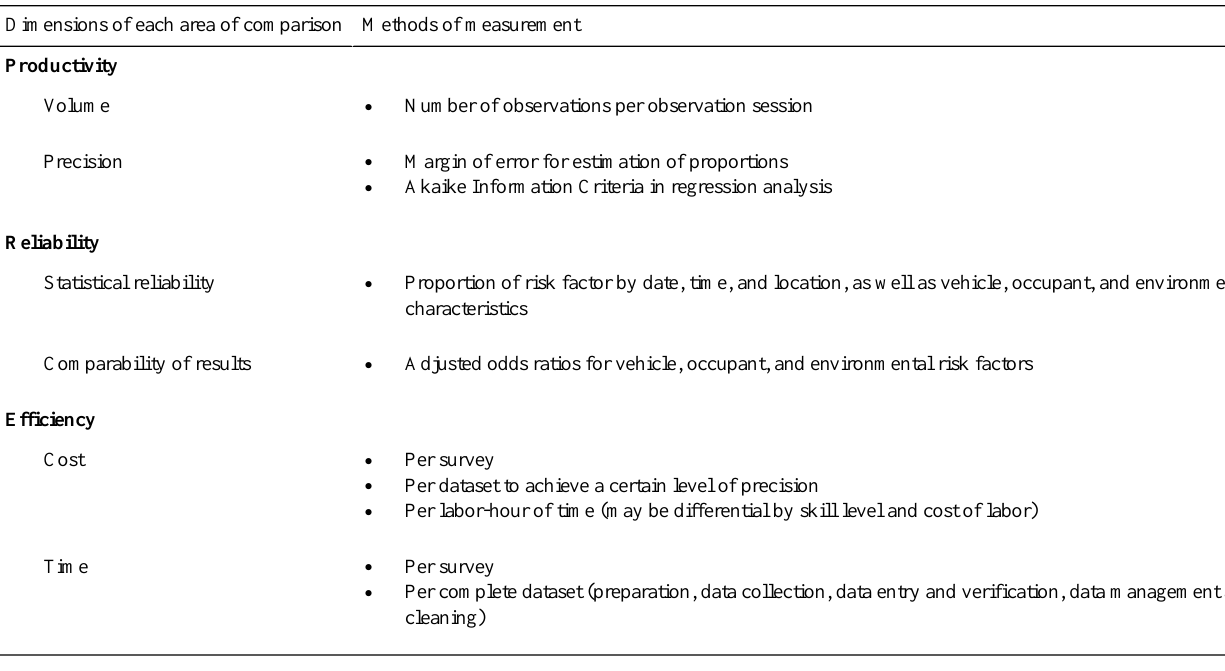
Table 1. Three areas of comparison between digital and paper data collection: productivity, reliability, and